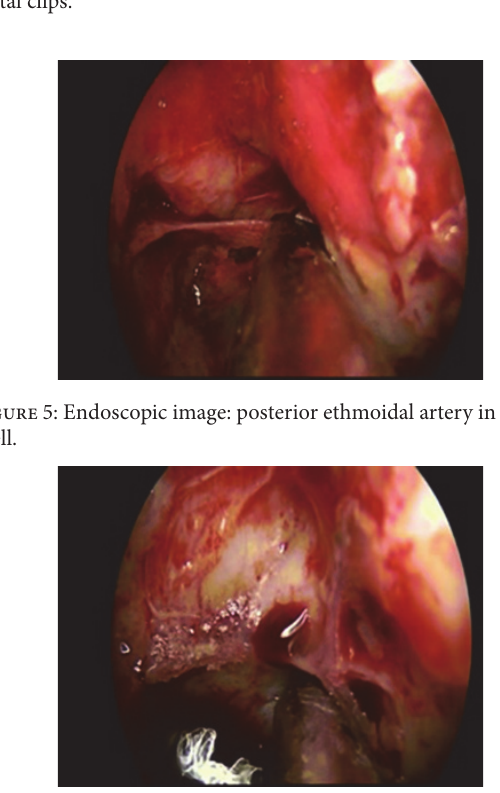
Figure 4: Endoscopic image: anterior ethmoid artery: closure with metal clips.